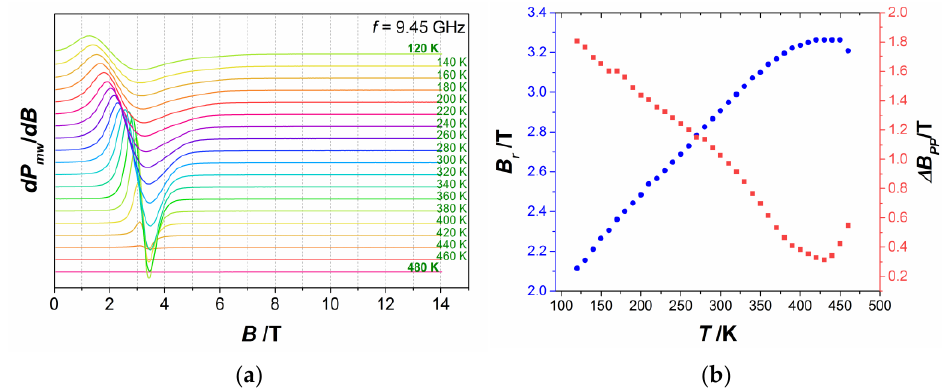
Figure 6. Temperature dependence of the EMR spectra ( a ), resonance field B r and peak-to-peak linewidth Δ B pp ( b ).